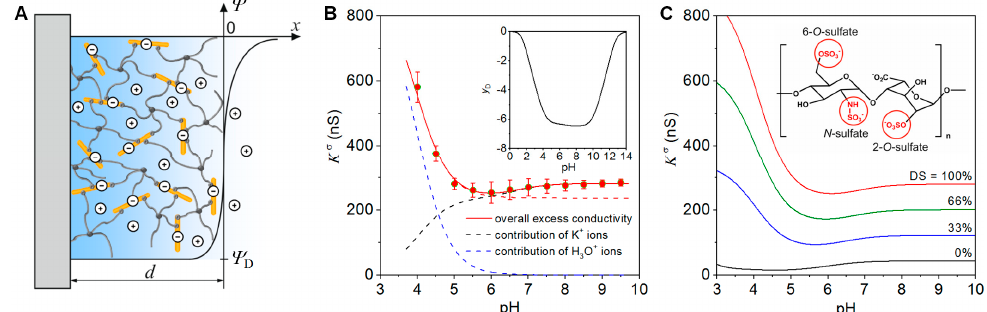
Figure 1. ( A ) Schematic representation of the model for the evaluation of surface conductivity data measured for starPEG-heparin hydrogel films. ( B ) Surface conductivity, K σ , and dimensionless Donnan potential, y D , of a starPEG-heparin hydrogel film with a thickness of ∼ 600 nm in 0.1 mM KCl solution at varying pH values. The experimental data (red circles) were reproduced by the theory (red solid line) using the double layer model shown in ( A ). The dashed lines represent the contribution of K + ions and H 3 O + ions to K σ . ( C ) Simulation curves illustrating the impact of desulfation on the surface conductivity of starPEG-hydrogel films. For further details see text and Reference [22]. Reprinted from [22] with permission, copyright American Chemical Society, 2012.